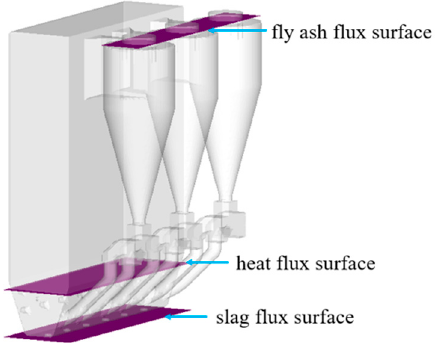
Figure 7. Model flux surface setting. Table 5. Input parameters for the simulations.